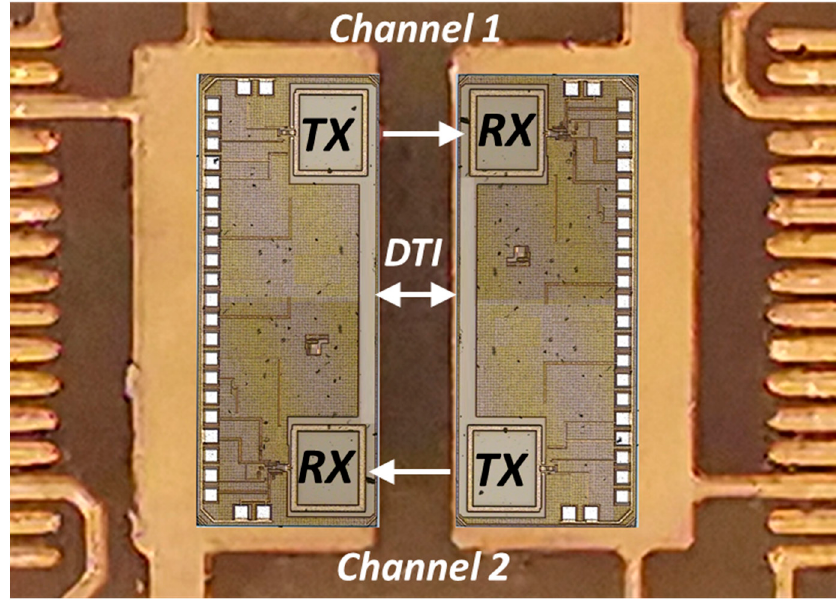
Figure 21. Bidirectional isolated data transfer system assembled on metal frame with 500-µm DTI. Table 3. Performance summary and comparison with the state-of-the-art of galvanic isolators. Parameters